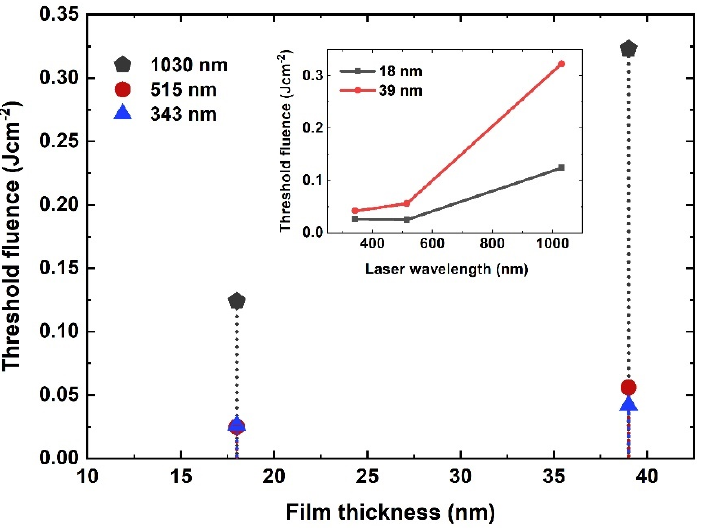
Figure 3. A comparison of threshold fluence with film thickness. The inset shows the variation in threshold fluence with employed laser wavelengths for 18-nm and 39-nm thick Au films, respec- tively.